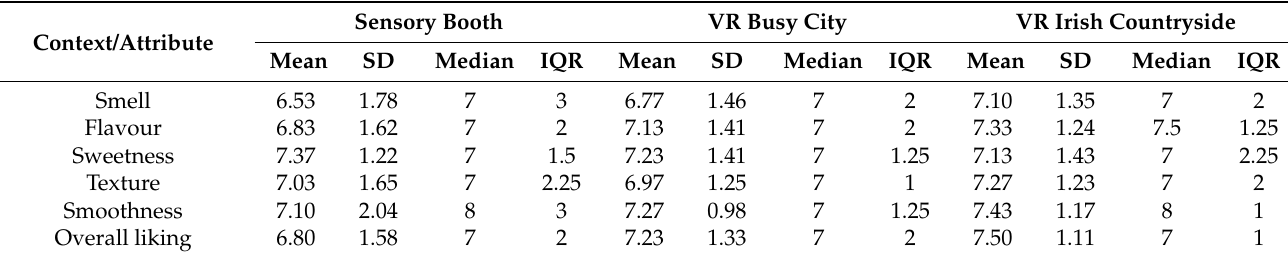
Table 2. Means, standard deviations (SD), medians and interquartile ranges (IQR) for participant hedonic rating * of chocolate in a traditional sensory booth, a VR busy city and a VR Irish countryside environment. Sensory Booth VR Busy City VR Irish Countryside Context/Attribute Mean SD Smell Flavour 6.83 Sweetness Texture Smoothness Overall